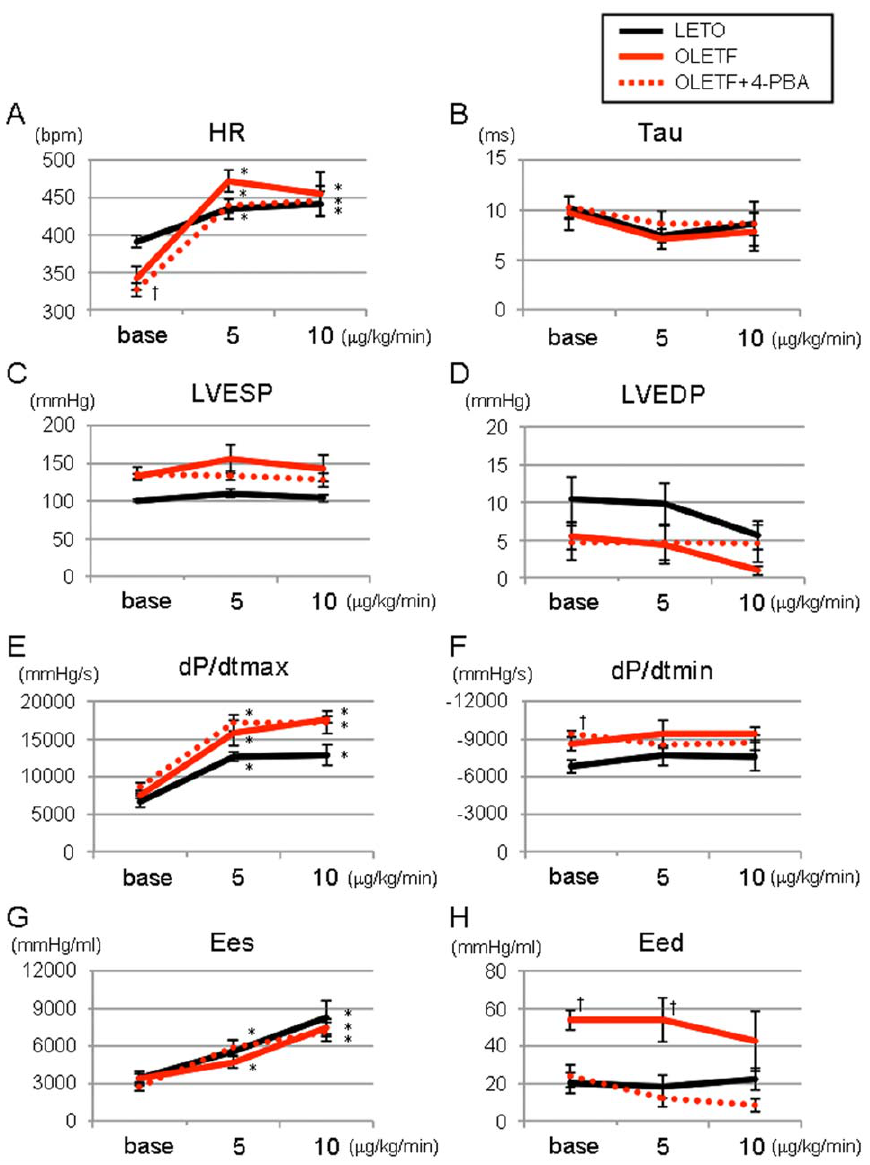
Figure 2. Responses of LV functions to b -adrenoceptor stimulation. Responses of heart rate (A), tau (B), LVESP (C), LVEDP (D), LVdP/dtmax (E), LVdP/dtmin (F), Ees (G) and Eed (H) to intravenous infusion of dobutamine are shown. *p , 0.05 vs. Baseline (Base), { p , 0.05 vs. LETO. n=5 , 6. tau= time constant of left ventricular pressure decay; LVESP= left ventricular end-systolic pressure; LVEDP= left ventricular end-diastolic pressure; LVdP/ dtmax= left ventricular maximal slope of the systolic pressure increment; LVdP/dtmin= left ventricular maximal slope of the diastolic pressure decrement; Ees= end-systolic elastance; Eed= end-diastolic elastance; 4-PBA=4-phenylbutyric acid. doi:10.1371/journal.pone.0039893.g002 dysfunction (Figure 1). Involvement of ER stress in the diastolic